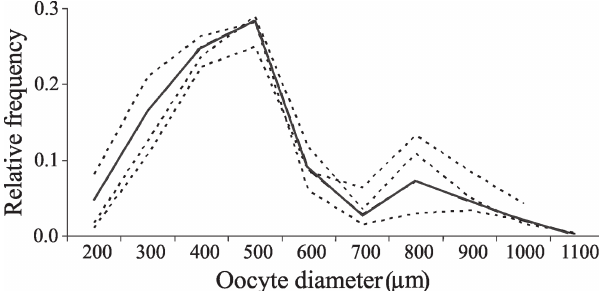
Fig. 6. Size frequency distributions of oocyte diameter grouped per 100 µm in actively spawning female Pinguipes brasilianus . Dotted lines show the relative frequencies for three different fish, and the solid line, the distribution obtained by pooling all